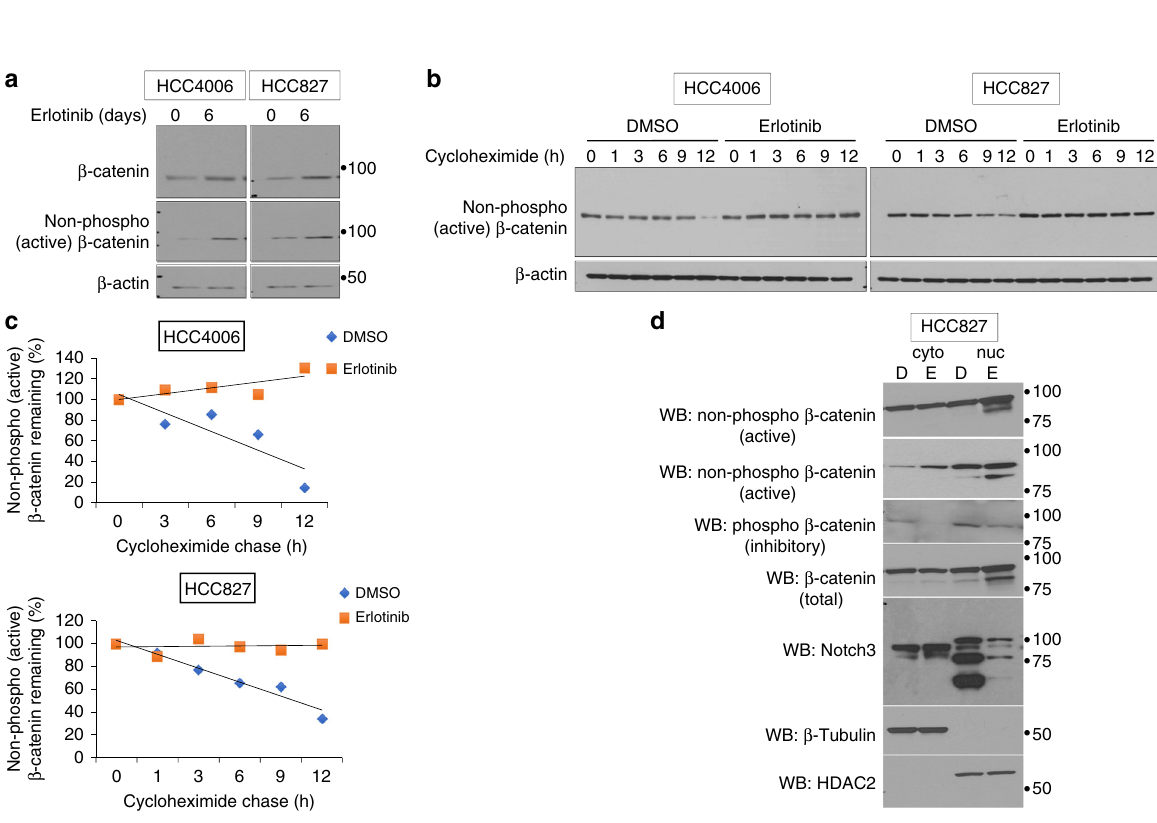
Fig. 4 EGFR TKI treatment increase β -catenin protein stability. a Cells were treated as described in Fig. 3 and were analyzed for the expression of total and non-phospho (active) β -catenin by WB using an antibody that recognizes the active form of β -catenin. b Cells were treated as described in Fig. 4 and prior to harvesting, cells were further treated with cycloheximide for the indicated times. Cell lysates were analyzed for non-phospho (active) β -catenin by western blot. c Western blots were quantitated and data plotted (trend line) as percentage of non-phospho β -catenin remaining as a function of cycloheximide treatment. d HCC827 cells were treated with erlotinib or DMSO and subjected to cytoplasmic and nuclear fractionation. Equal amounts of total protein from each fraction was analyzed for β -catenin (active, inactive, and total), Notch3, β -tubulin, and HDAC2. Error bars represent SD